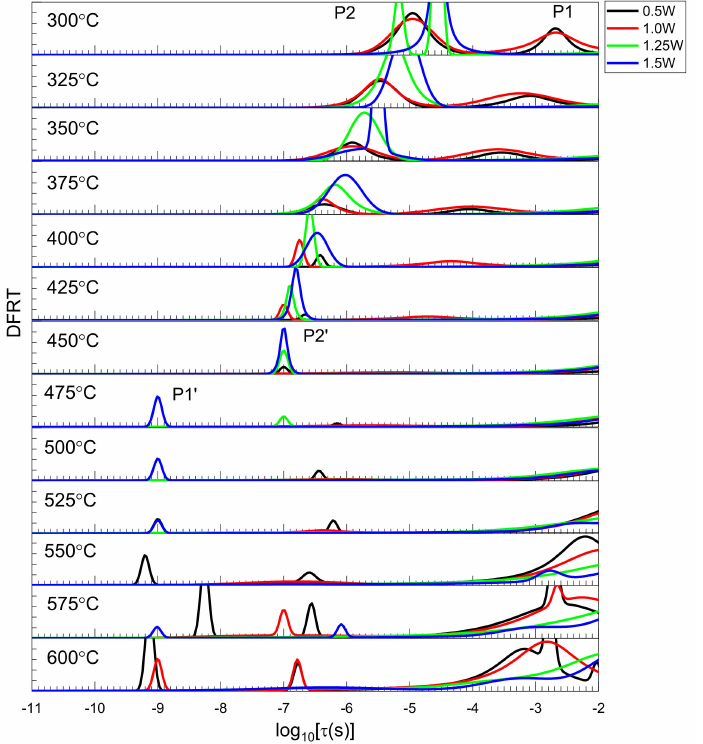
Figure 6. DFRT plots at different temperatures and compositions. Some peak heights are truncated for better